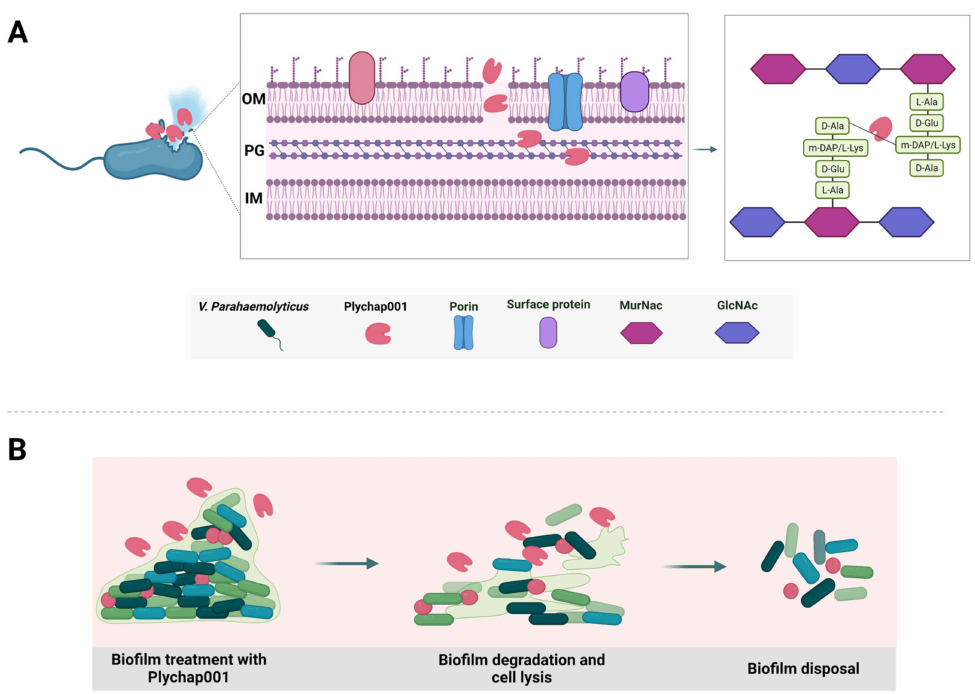
Scheme 1. ( A ) Schematic diagram depicting the extracellular application of Plychap001